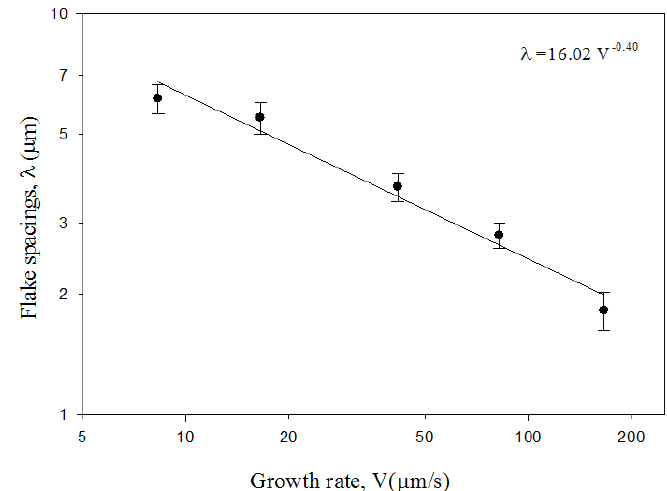
Fig 3. Variation of flake spacings as a function of growth rate.